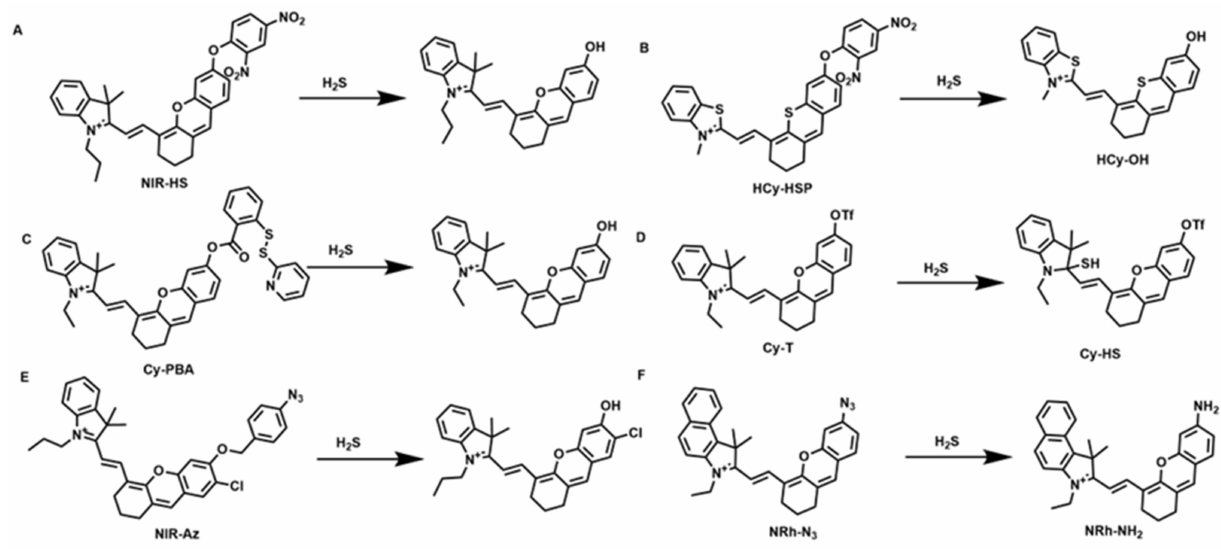
Figure 10. The response mechanisms and chemical structures ( A ) NIR-HS, ( B ) HCy-HSP, ( C ) Cy-PBA, ( D ) Cy-T, ( E ) NIR-Az and ( F ) NRh-N 3 of fluorescent probes for H 2